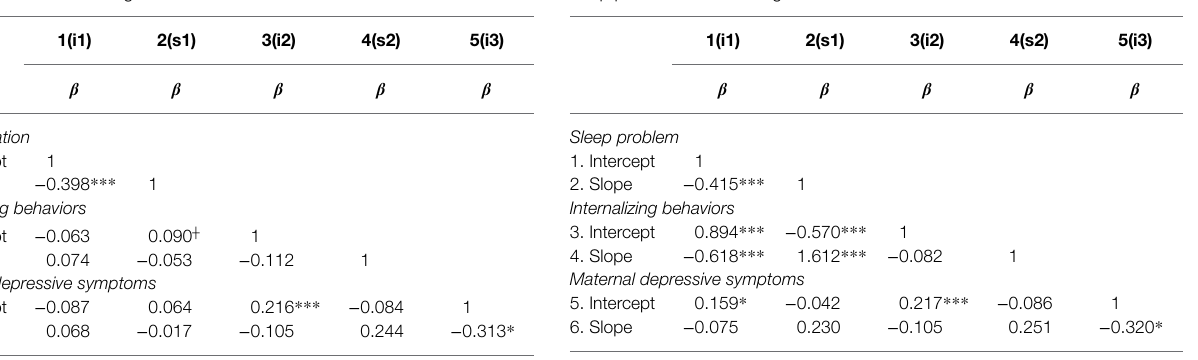
TABLE 5 | Coefficients among growth factors in multivariate growth model 2: sleep duration—internalizing behaviors.